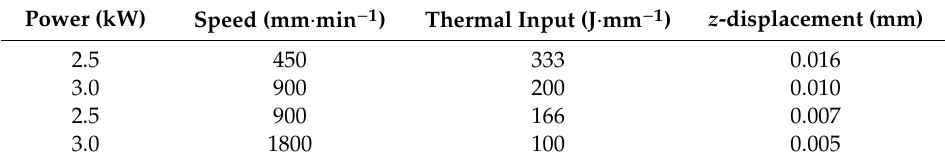
Figure 21. Displacement of the point of interest as a function of time; single deposition, 3.0 kW power, 1800 mm ∙ min − 1 speed and 3 g ∙ min − 1 feeding. Table 9. Displacement of the point of interest as a function of delivered thermal input, for given feeding rate of 3 g ∙ min − 1 .